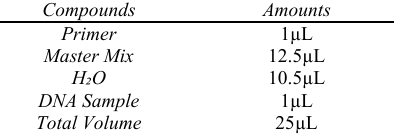
Table 3: Components needed for PCR